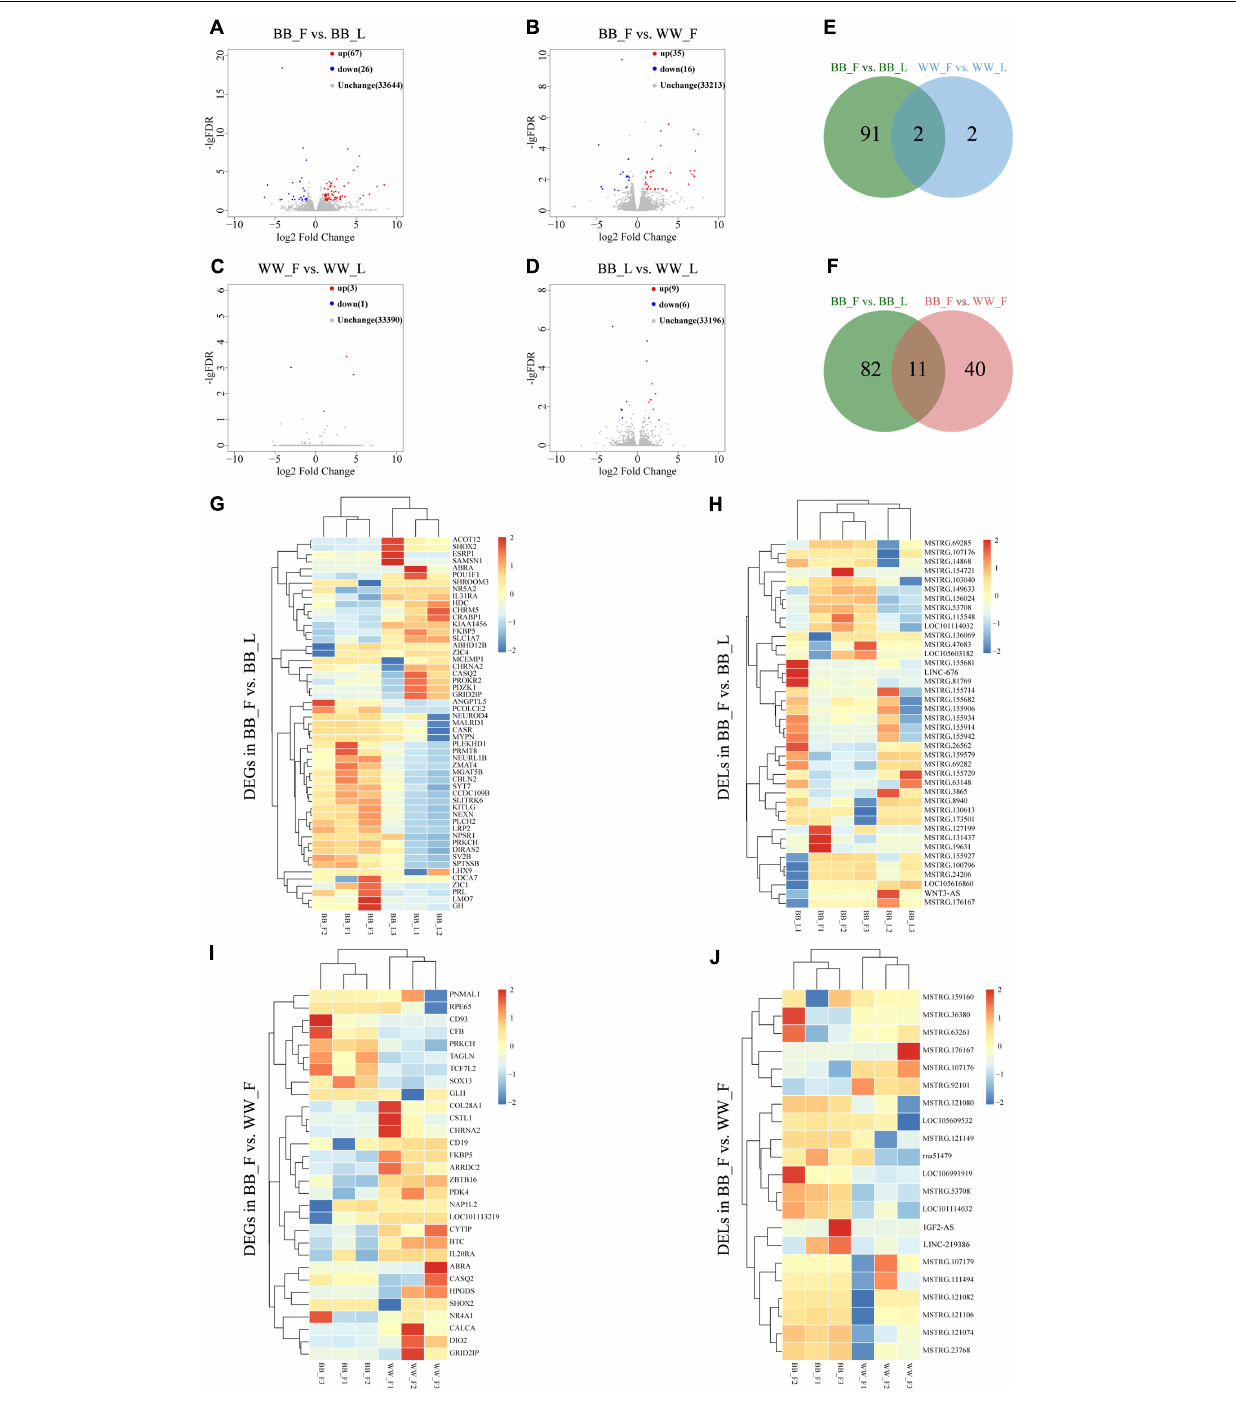
FIGURE 2 | The analysis of DELs and DEGs. (A) Volcano showing the upregulated and downregulated genes in the BB_F vs. BB_L. (B) Volcano showing the upregulated and downregulated genes in the BB_F vs. WW_F. (C) Volcano showing the upregulated and downregulated genes WW_F vs. WW_L. (D) Volcano showing the upregulated and downregulated genes BB_L vs. WW_L. (E) Venn showing analysis of unique and shared DEGs and DELs between follicular and luteal phases. (F) Venn showing analysis of unique and shared DEGs and DELs between genotype BB and WW in the follicular phase. (G) Hierarchical cluster of DEGs in the BB_F vs. BB_L, where all the FPKM values of genes were normalized by log 2 (FPKM). (H) Hierarchical cluster of DELs in the BB_F vs. BB_L, where all the FPKM values of known and novel lncRNAs were normalized by log 2 (FPKM). (I) Hierarchical cluster of DEGs in the BB_F vs. WW_F, where all the FPKM values of genes were normalized by log 2 (FPKM). (J) Hierarchical cluster of DELs in the BB_F vs. WW_F, where all the FPKM values of known and novel lncRNAs were normalized by log 2